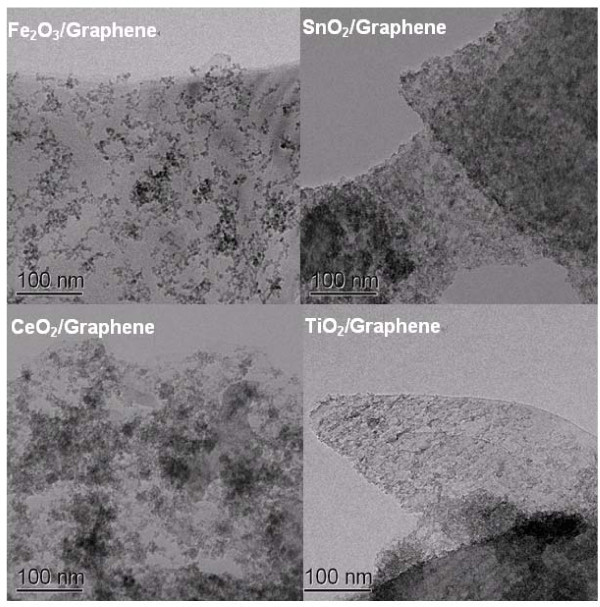
TEM images of various metal oxide NPs of Fe2O3, SnO2, CeO2, and TiO2 on a few-layer graphene.